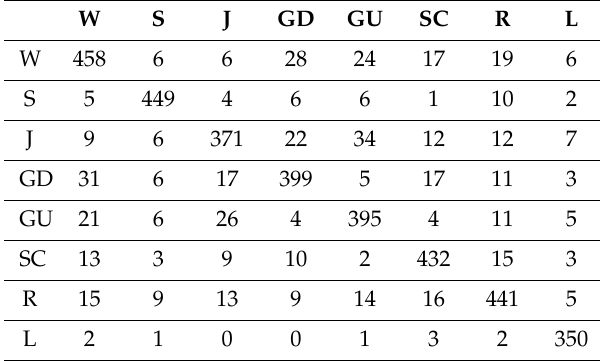
Table 4. Confusion matrix for human activity recognition (HAR) using 20 base classifiers based on principal component analysis (PCA) features.